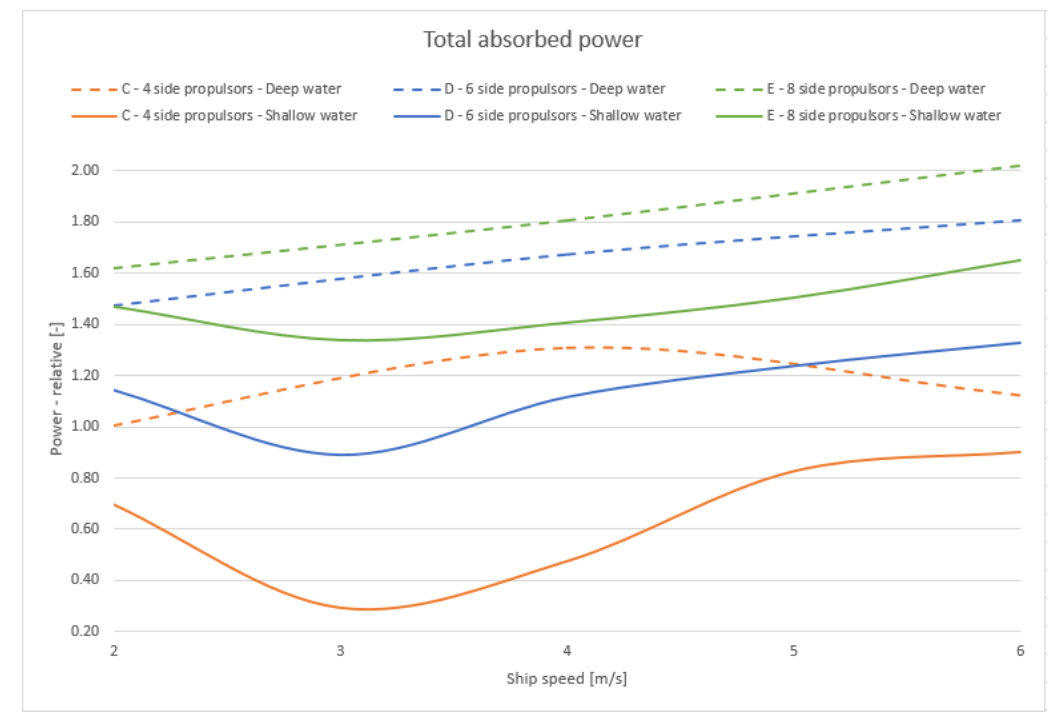
Figure 16. Power of distributed systems in deep and shallow water conditions. Source: Authors.